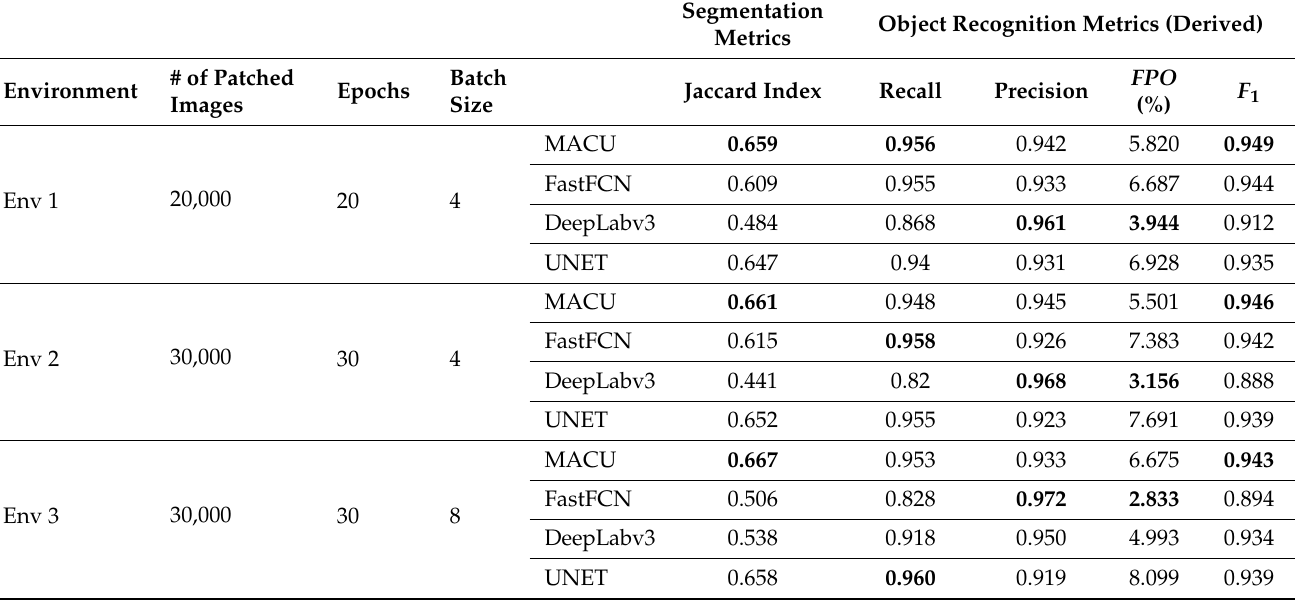
Table 2. Performance of four neural networks in three different training